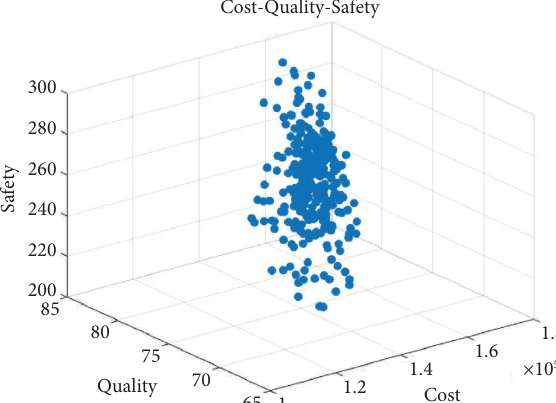
Figure 23: Cost-quality-safety trade-of.